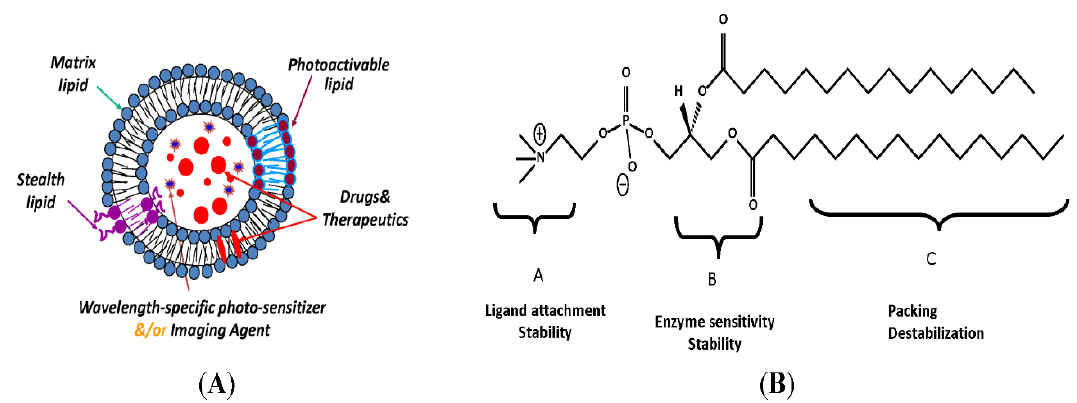
Figure 4. ( A ) Photo-sensitive liposomal assembly. Drugs (red), imaging agents and / or second photosensitizer (bright blue) are encapsulated in the liposomes. ( B ) Chemical structure shown as a prototype. The three lipid parts—that is, the head, glycerol backbone and fatty acyl chains—can be modified to generate photo-sensitive materials. Adapted and modified with permission from [81].